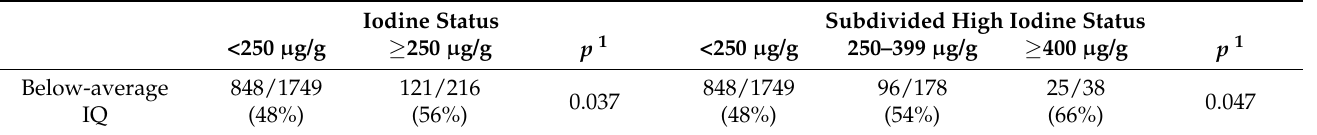
Table 1. Proportion of school children (ages 6 through 12 years) presenting below-average IQs by iodine status ( N = 1965).